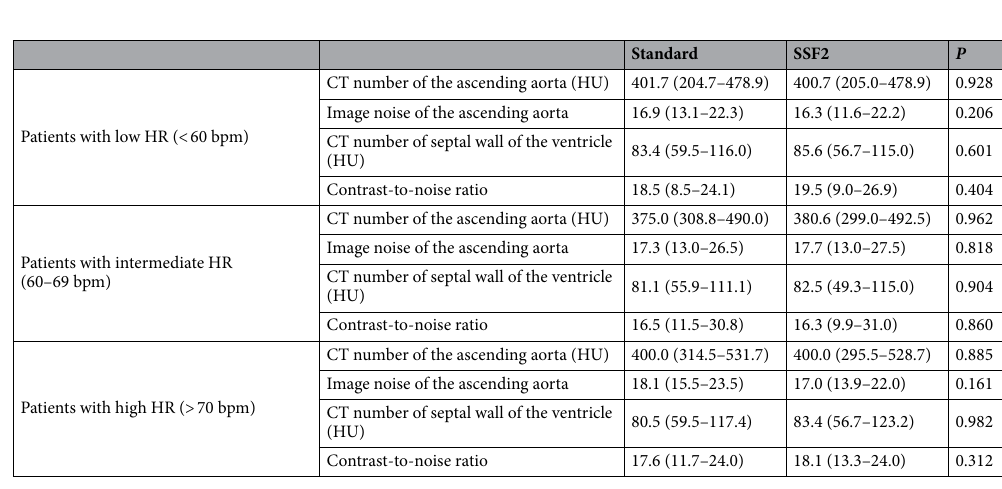
Table 6. CT number, image noise and contrast-to-noise ratio at each site. HR Heart rate, HU Hounsfield units. Values are the median (range).